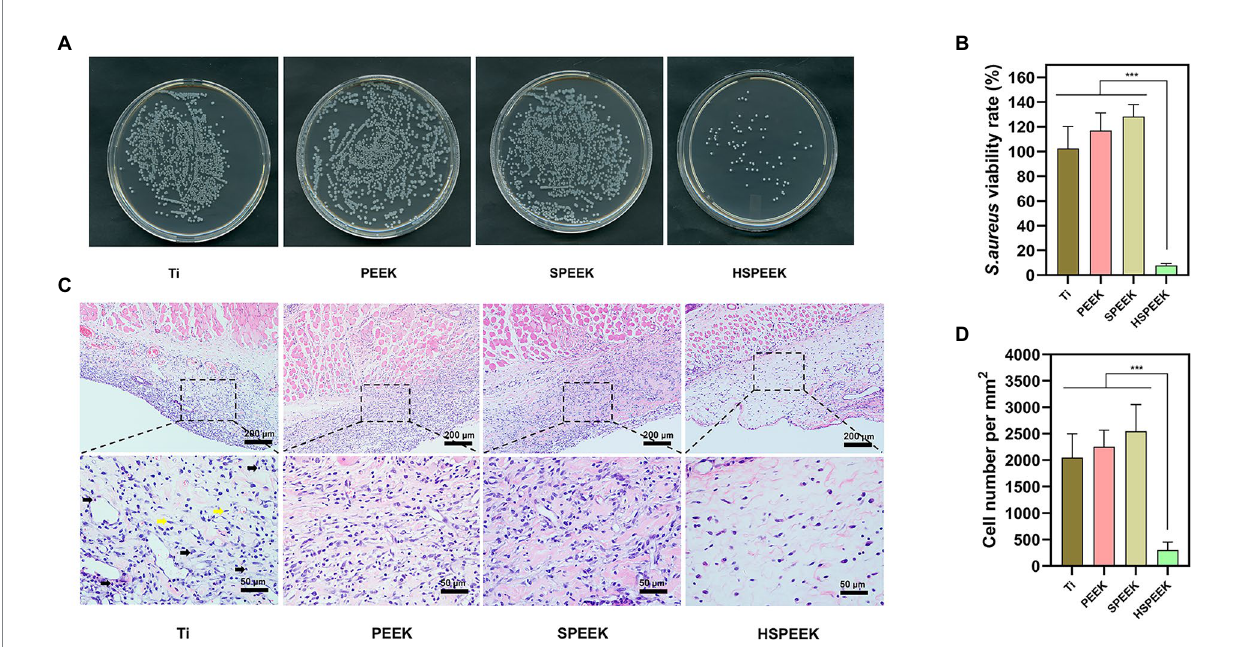
FIGURE 5 (A) Images of S. aureus colonies on the surface of Ti, PEEK, SPEEK and HSPEEK, (B) S. aureus viability rate on the surface of each group of samples, (C) H&E staining results of soft tissue surrounding each group of samples. Black arrows represent inflammatory cells and yellow arrows represent healthy tissue cells, and (D) The density of inflammatory cells in the surrounding soft tissue of each group of samples. ( n = 4, *** p <